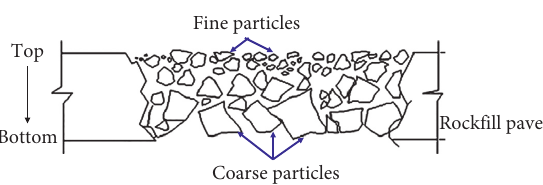
Figure 4: Segregation of field rockfill pavement (Modified from Cooke [5]).